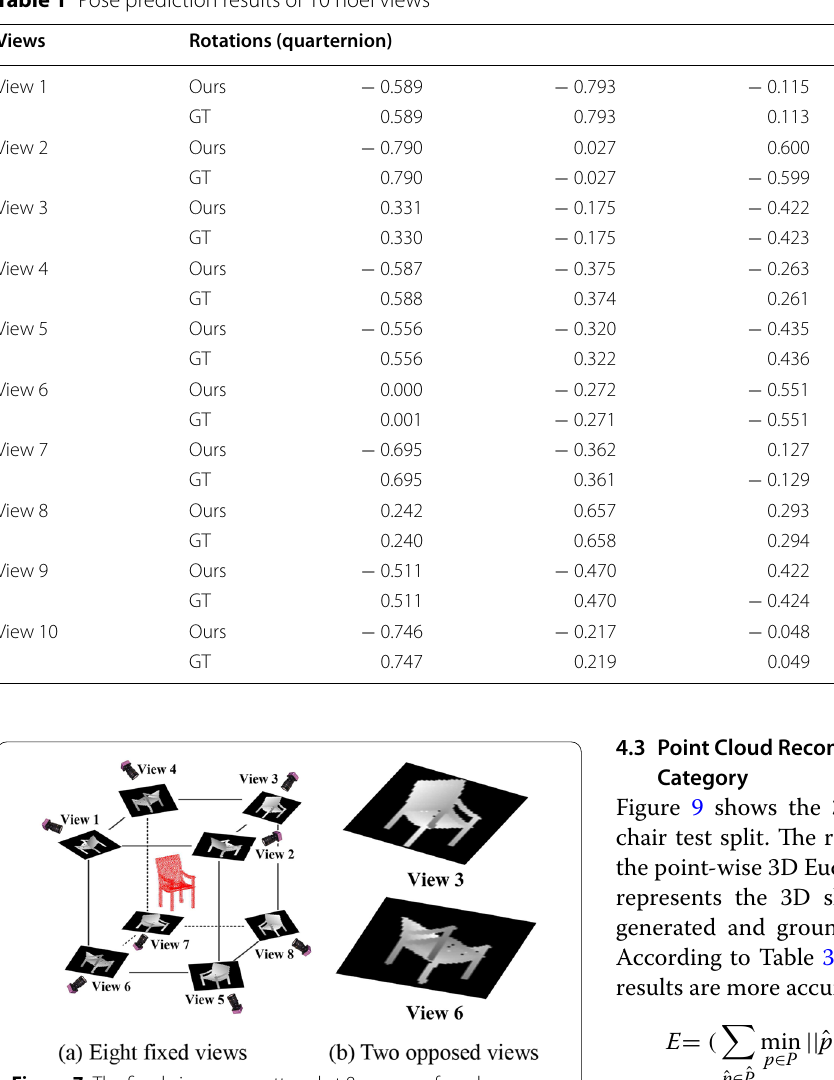
Table 1 Pose prediction results of 10 noel views Views